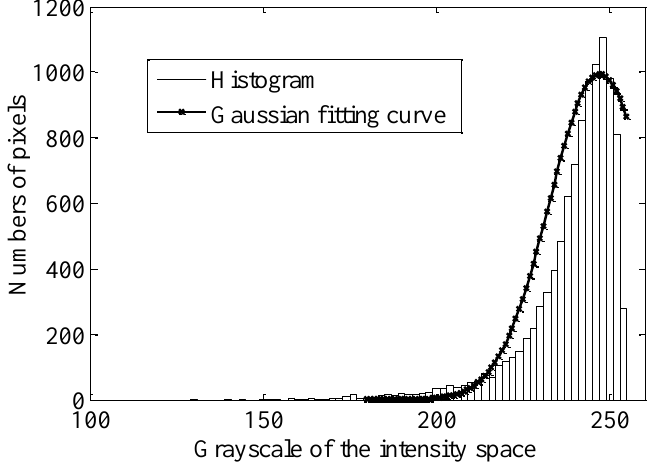
Figure 2. Histogram illustrating the brightness distribution of taillight